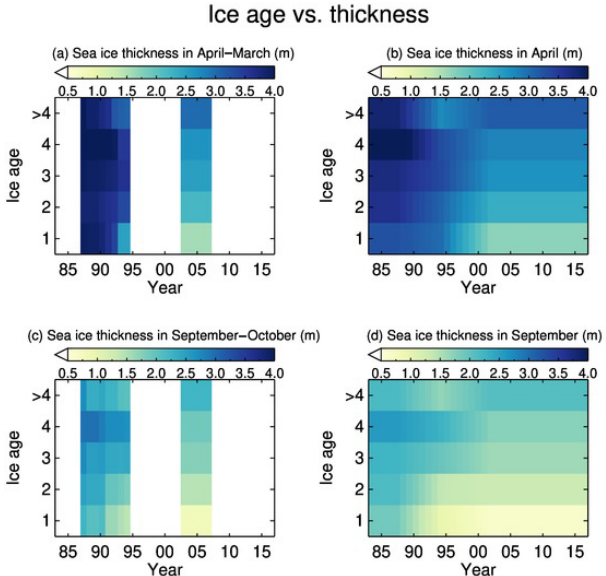
Figure 2. Observed relationship of ice age and ice thickness from 1988 to 1995 from submarine data in April (a) and September (c) and from 2004 to 2008 from ICESat in March (a) and October (c) and the derived relationship of ice age and ice thickness from 1984 to 2018 in April (b) and September (d)